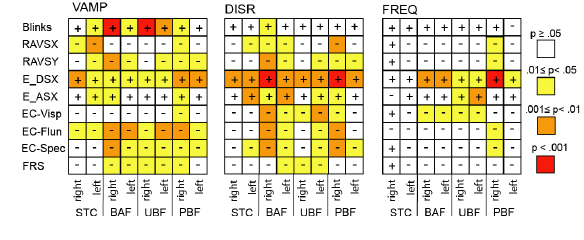
Fig. 4 Correlation of saccadic intrusion parameters with oculomotor and neuropsychologic scores in ALS patients. The matrices represent the sign and significance level of Spearman's rank correlation coefficients of (1) the vectorial